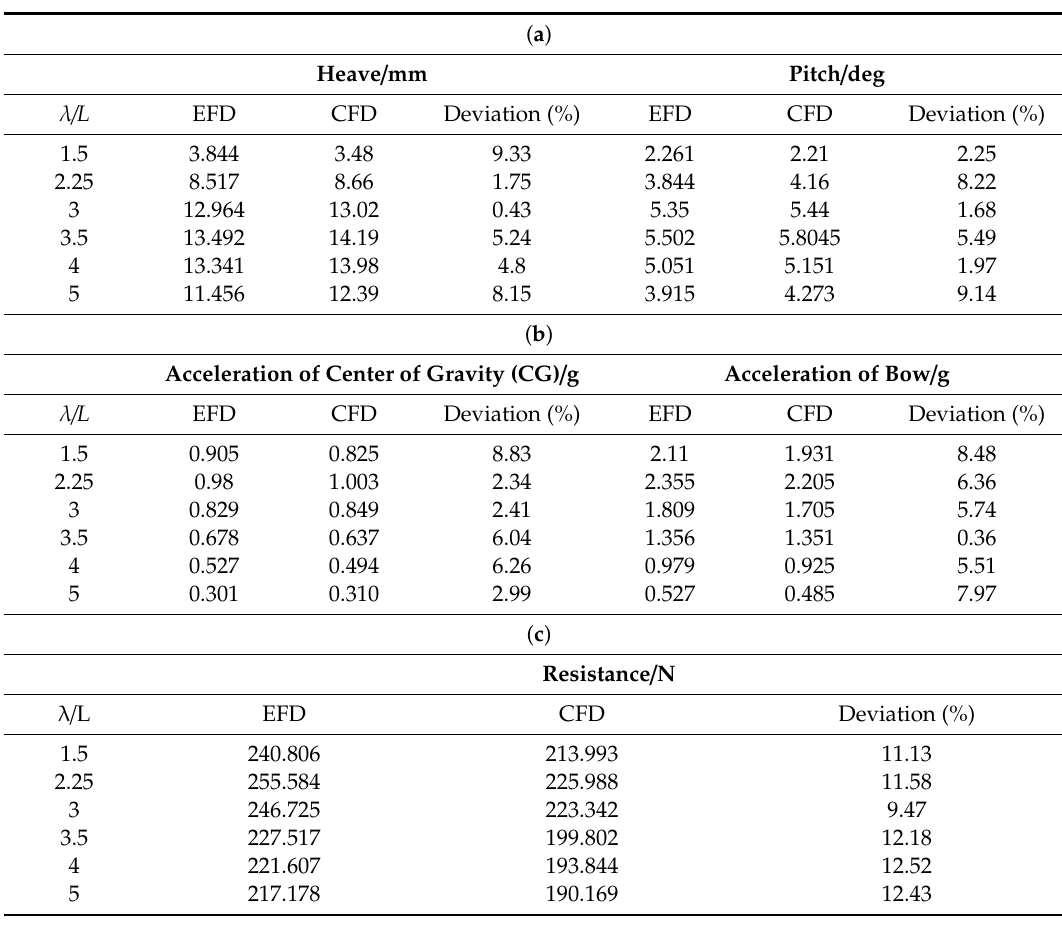
Table 8. Numerical and test results of the response amplitude operators (RAOs) and resistance: ( a ) Heave and pitch; ( b ) Acceleration; ( c )